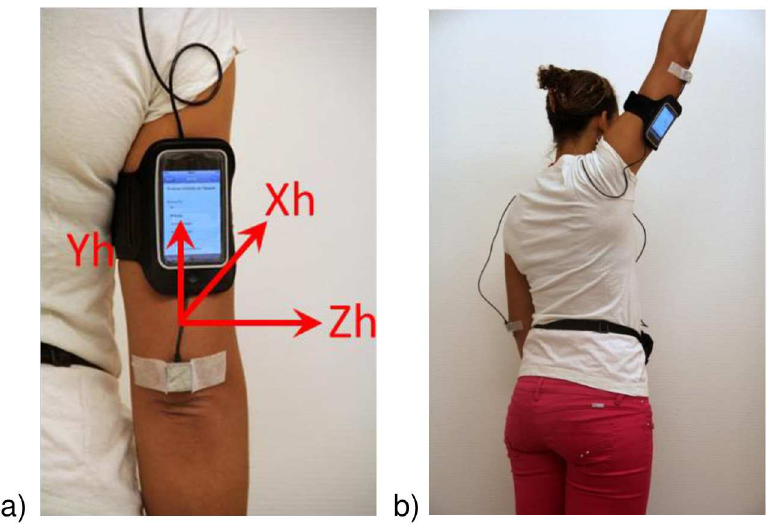
Fig 2. Inertial sensors and smartphone placement and axes. (a) The inertialsensor module(Physilog ® reference system) attached to the arm with medicaltape and connected by cable to the dataloggercarried on wait. The smartphone is attached to the arm with the armband. (b) Test completionof “hand to the ceiling”.